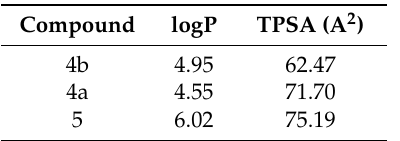
Table 2. TPSA and logP values of dibenzo[ b , d ]furan